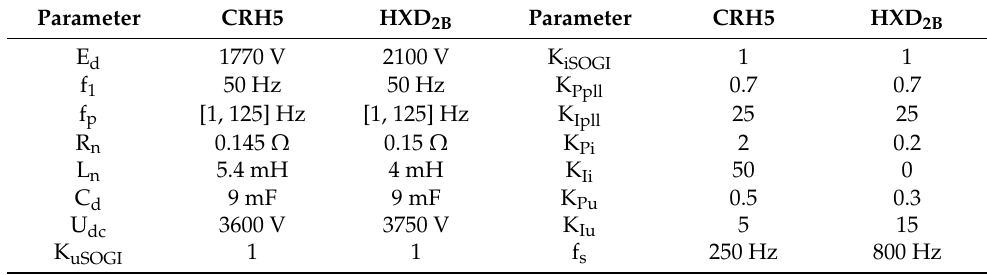
Table 1. Parameters of